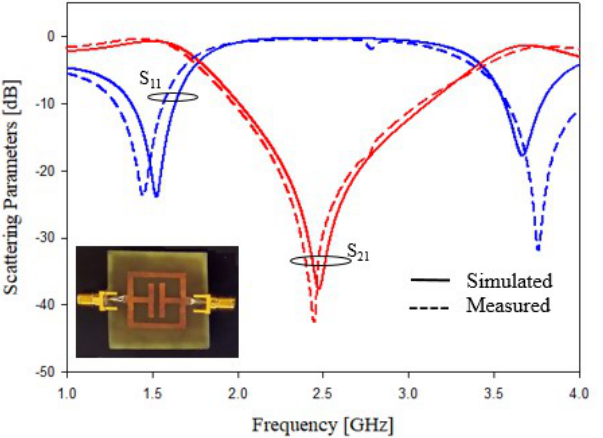
Figure 15. Experimental assessment, T-shapes stubs, prototype of Figure 5a. Comparisons between numerical and measured scattering